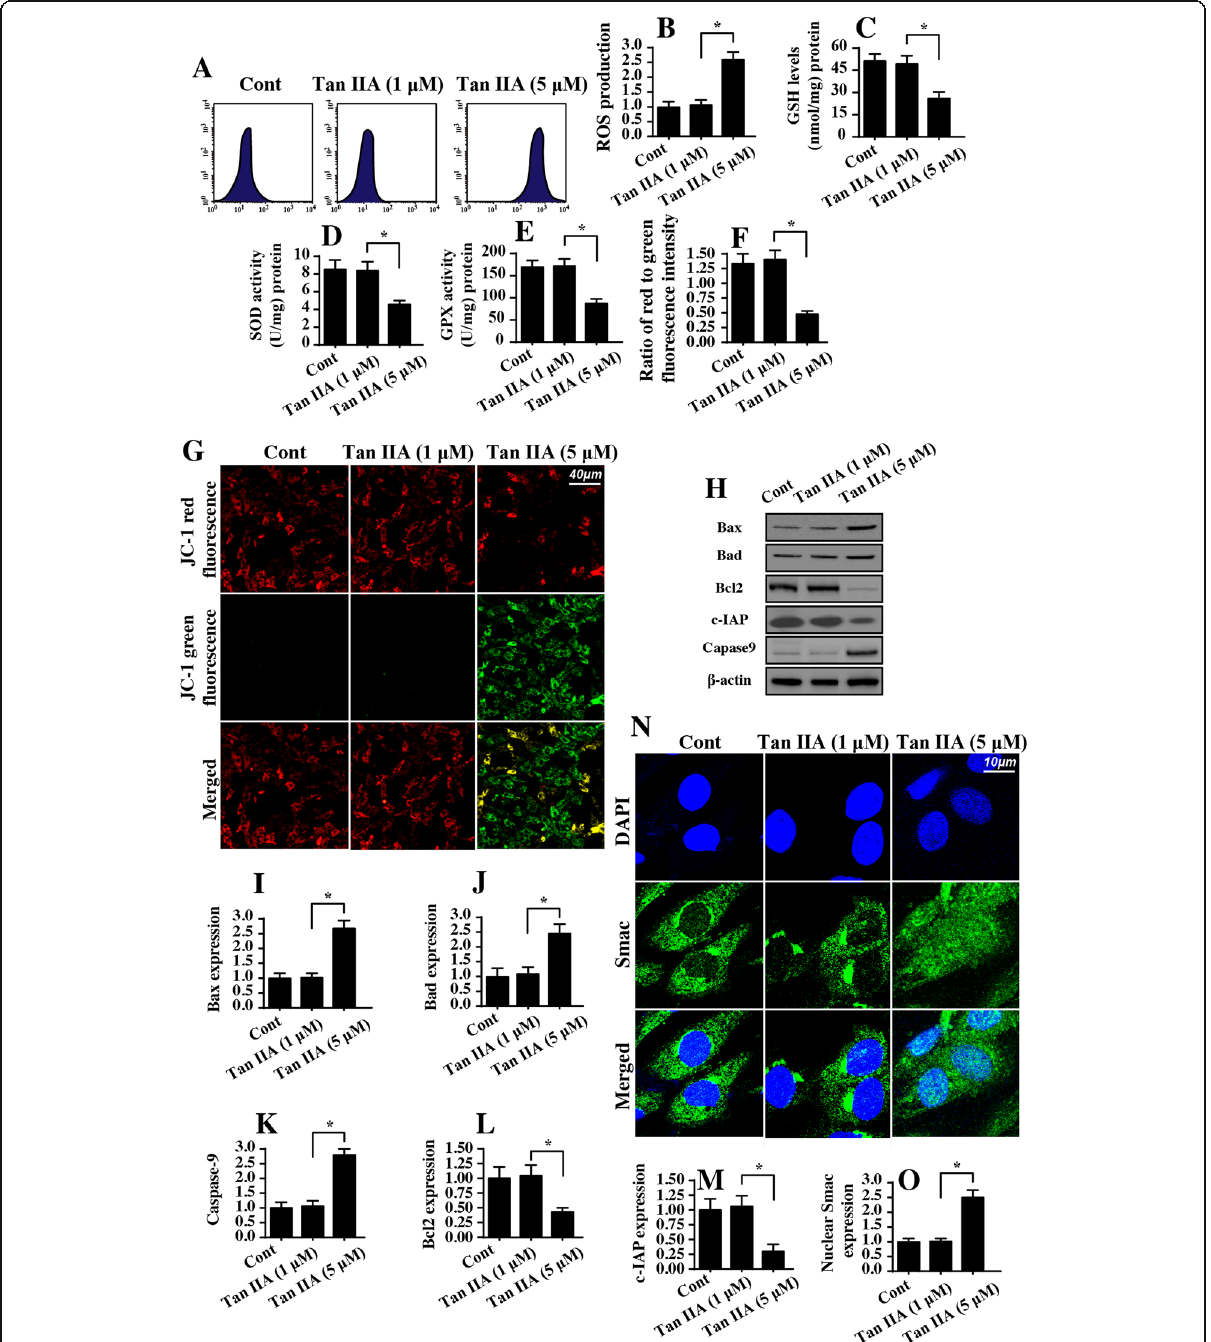
Fig. 3 Tan IIA promotes mitochondrial injury. a-b Mitochondrial ROS production was measured via flow cytometry using MitoSOX ™ Red Mitochondrial Superoxide Indicator. Tan IIA at 1 μ M and 5 μ M were incubated with SW837 cells for 12 h. c-e The antioxidant factors, including GSH, SOD and GPX were quantified via ELISA in SW837 cells treated with Tan IIA. f-g Mitochondrial potential was observed using JC-1 staining and quantified by evaluating the ratio of red-to-green fluorescence intensity. h-m The alterations of mitochondrial proapoptotic and antiapoptotic proteins were detected using Western blotting. n-o Immunofluorescence assay for Smac. Blue fluorescence is the DAPI probe, which stained the nucleus. * p <